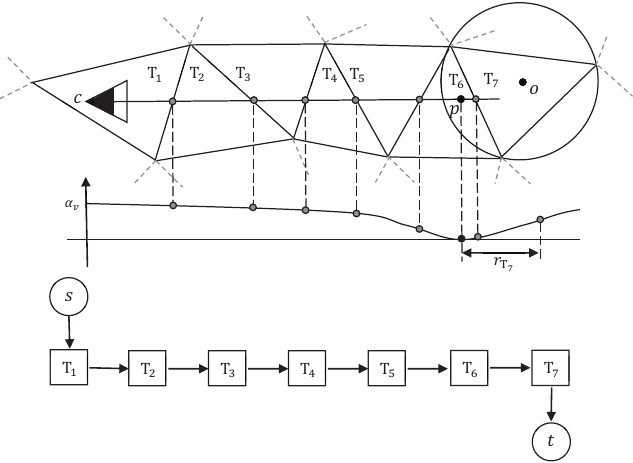
Figure 9. The modified version of our visibility model in 2D. In this visibility model, for a single line of sight v , how to assign weight (energy) to the tetrahedron containing camera center, the end tetrahedron and the facets intersected by ( c , p ) or its extension is